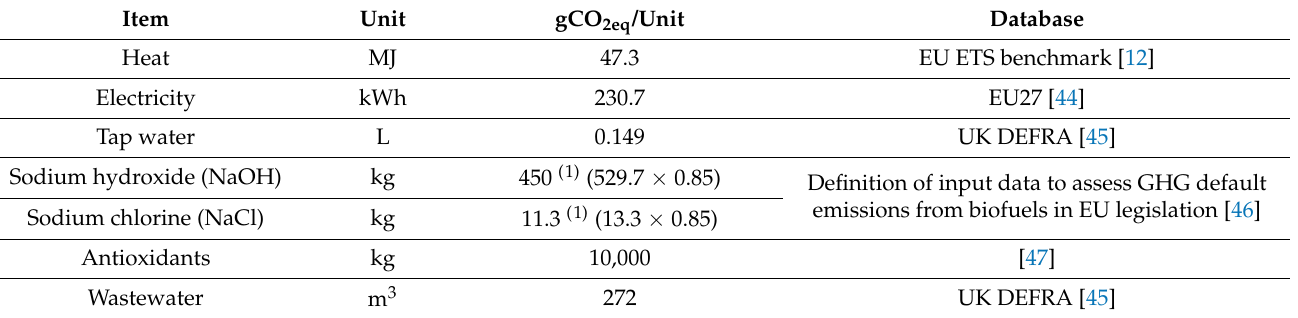
Figure 7. Reduction fishery generic data input and output [43]. Table 3. Selected emission factors.